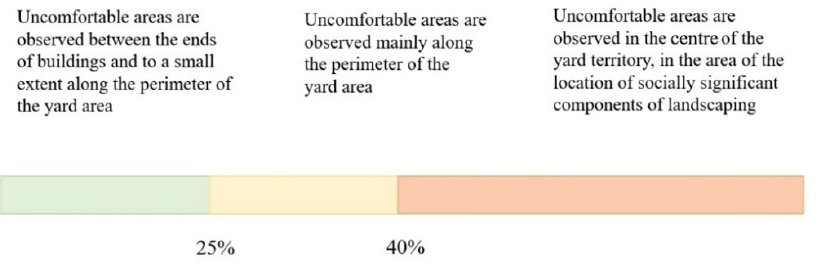
Figure 15. Graded aeration comfort of the residential development on the sloping lands of the AZRF.